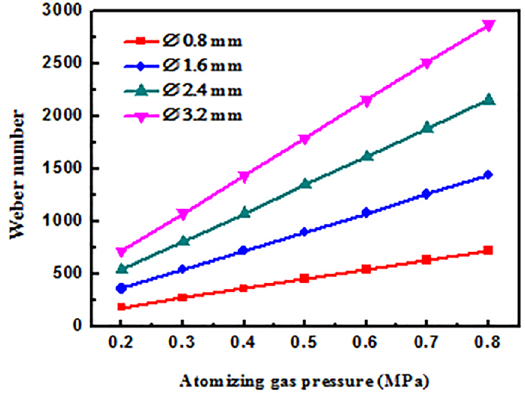
Figure 6. Relationships between atomizing gas pressure and Weber number